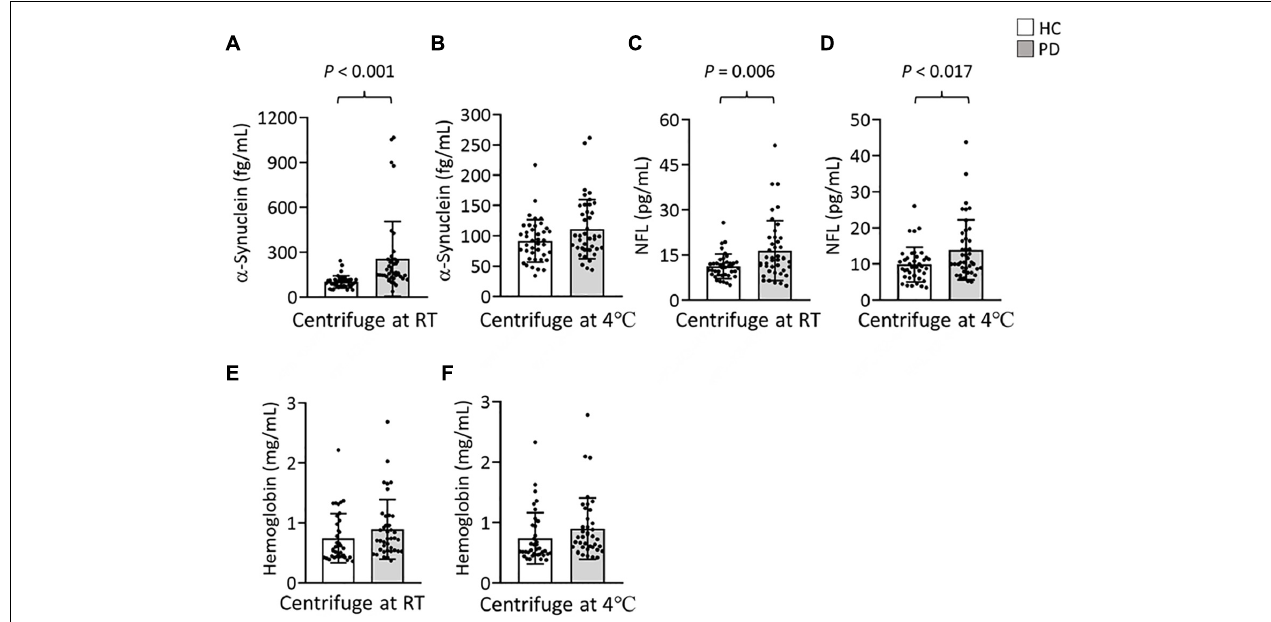
FIGURE 4 | Levels of α -synuclein and NFL in the plasma of patients with PD and HCs. (A,B) Plasma levels of α -synuclein in patients with PD ( n = 42) and HCs ( n = 40) in K 2 -EDTA tubes centrifuged at (A) RT or (B) 4 ◦ C. (C,D) Plasma levels of NFL in patients with PD and HCs in K 2 -EDTA tubes centrifuged at (C) RT or (D) 4 ◦ C. (E,F) Plasma levels of hemoglobin in patients with PD and HCs in K 2 -EDTA tubes centrifuged at (E) RT or (F) 4 ◦ C. Error bars represent SD . Comparisons by Student’s t- test.